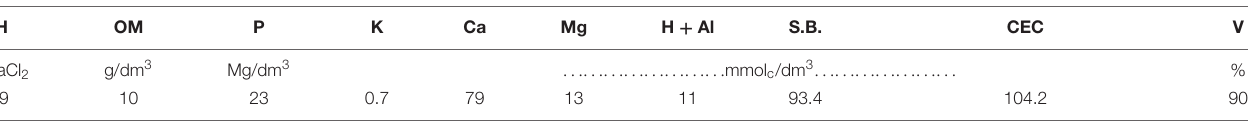
TABLE 2 | Analysis of soil used in greenhouse and field